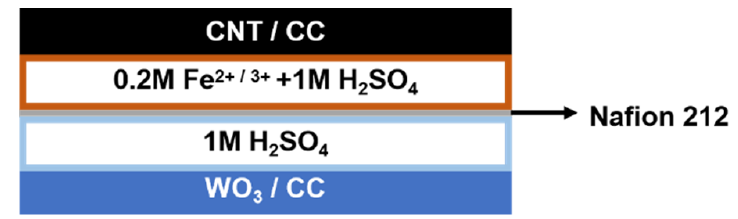
Figure 1. Schematic diagram illustrating the assembly of the ASC